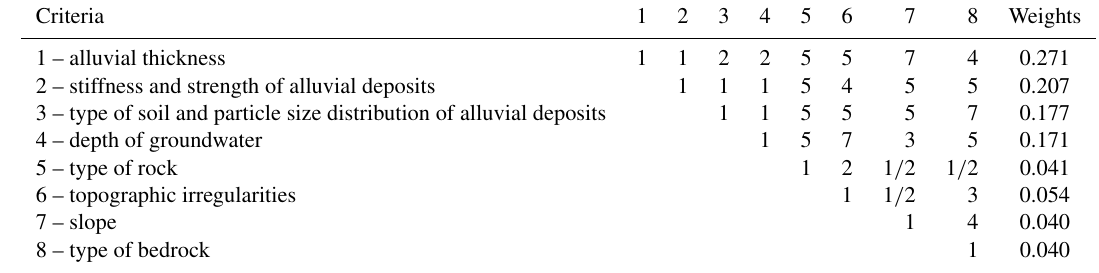
Table 3. The results of pair-wise comparisons of the selected criteria based on the AHP matrix. Criteria